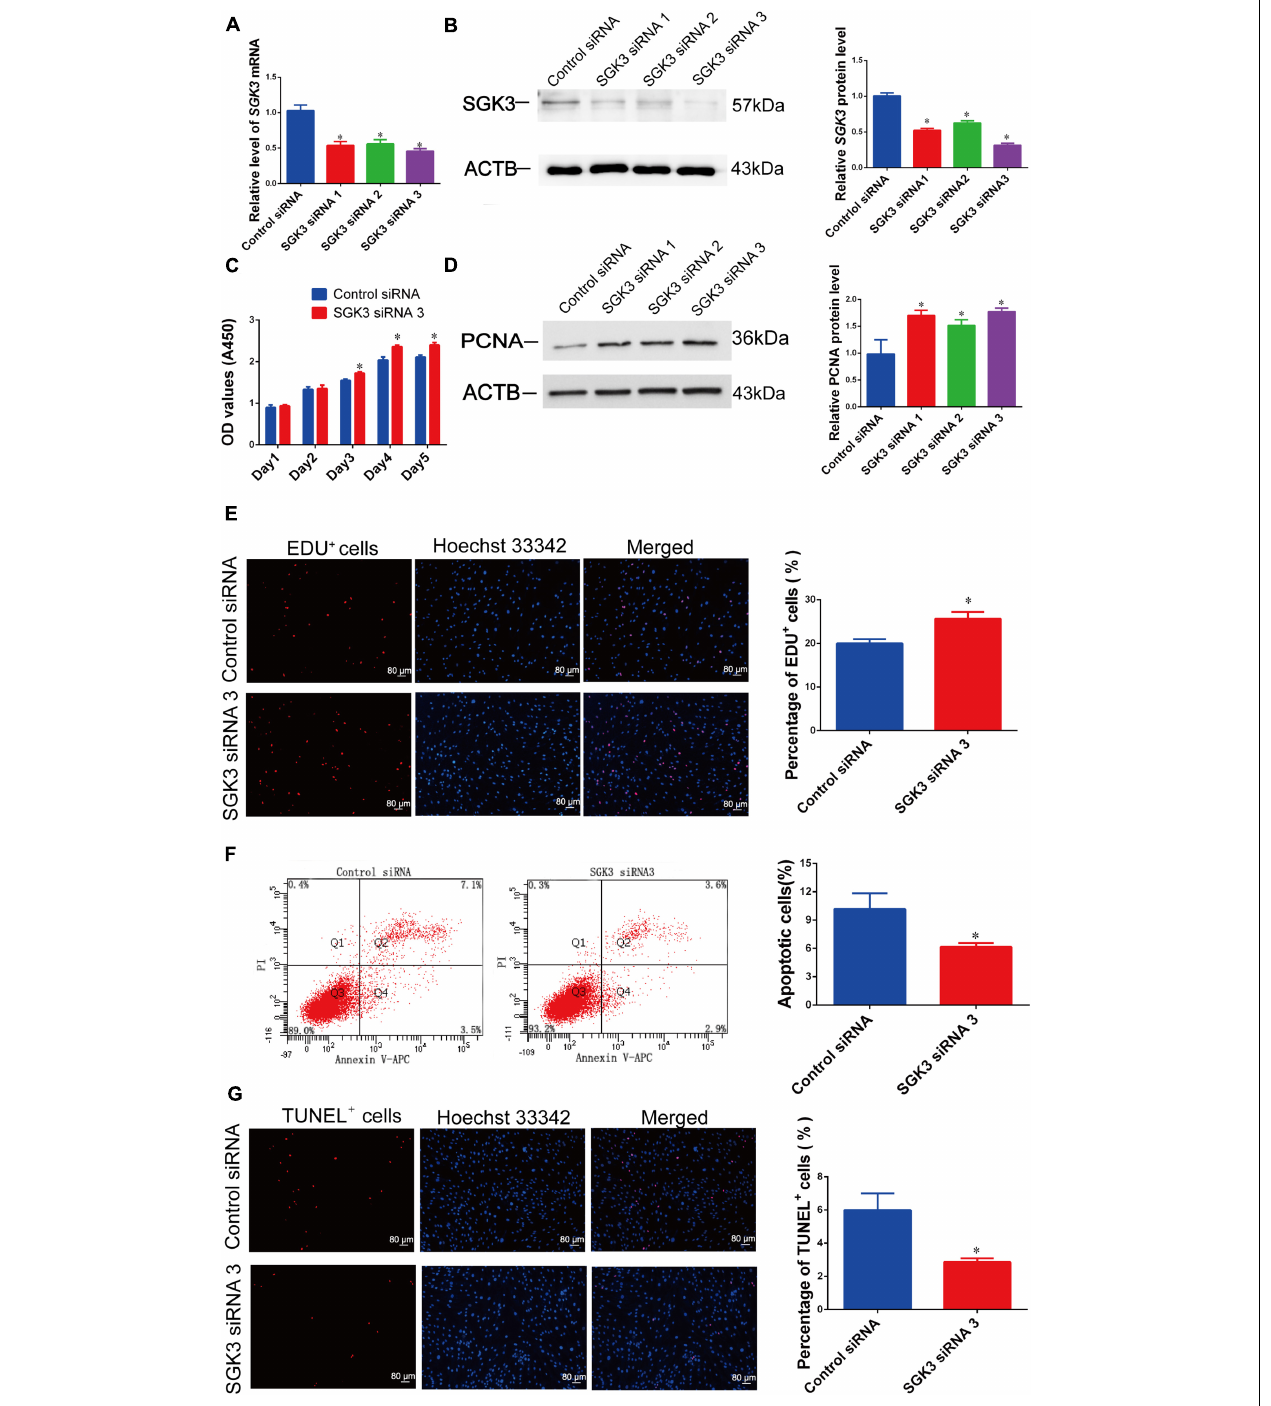
FIGURE 6 | Serum/glucocorticoid regulated kinase family member 3 (SGK3) knockdown regulates human Sertoli cell proliferation, DNA synthesis, and apoptosis. (A) The relative levels of SGK3 mRNA in human Sertoli cells after transfection of SGK3 siRNA 1–3 or the control siRNA. (B) The relative level of SGK3 protein in human Sertoli cells after transfection of SGK3 siRNA 1-3 or the control siRNA. (C) The cell growth of human Sertoli cells treated with SGK3 siRNA 3 and the control siRNA for 5 days. (D) The relative level of proliferating cell nuclear antigen (PCNA) protein in human Sertoli cells at day 3 transfected by SGK3 siRNA 1-3 or the control siRNA. (E) The 5-ethynyl-2 (cid:48) -deoxyuridine (EdU)-positive cells of human Sertoli cells treated with SGK3 siRNA 3 or the control siRNA. Scale bar in panel (E) = 80 µ m. (F) The percentages of apoptosis in human Sertoli cells transfected with control siRNA or SGK3 siRNA 3. (G) The percentages of terminal deoxynucleotidyl transferase dUTP nick end labeling (TUNEL)-positive cells in human Sertoli cells transfected with control siRNA or SGK3 siRNA 3. Scale bar in panels (E,G) = 80 µ m. * indicated the statistical difference between SGK3 siRNAs and the control siRNA.